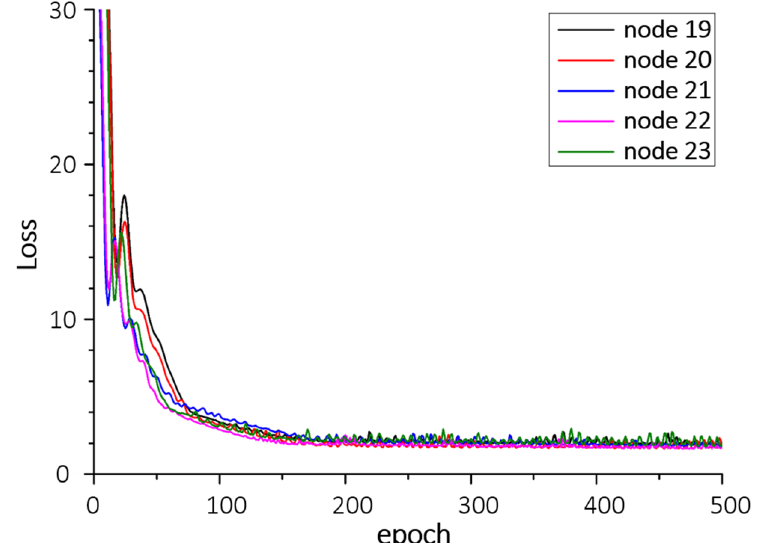
Figure A3. Tuning result of the ANN.